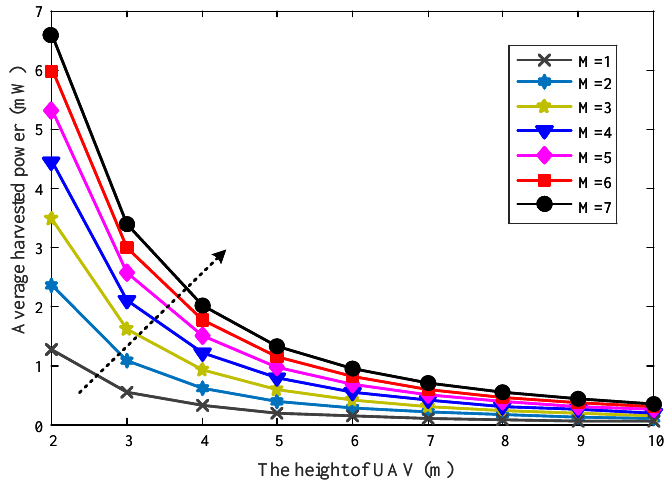
Figure 6. The average received power versus the UAV’s height H